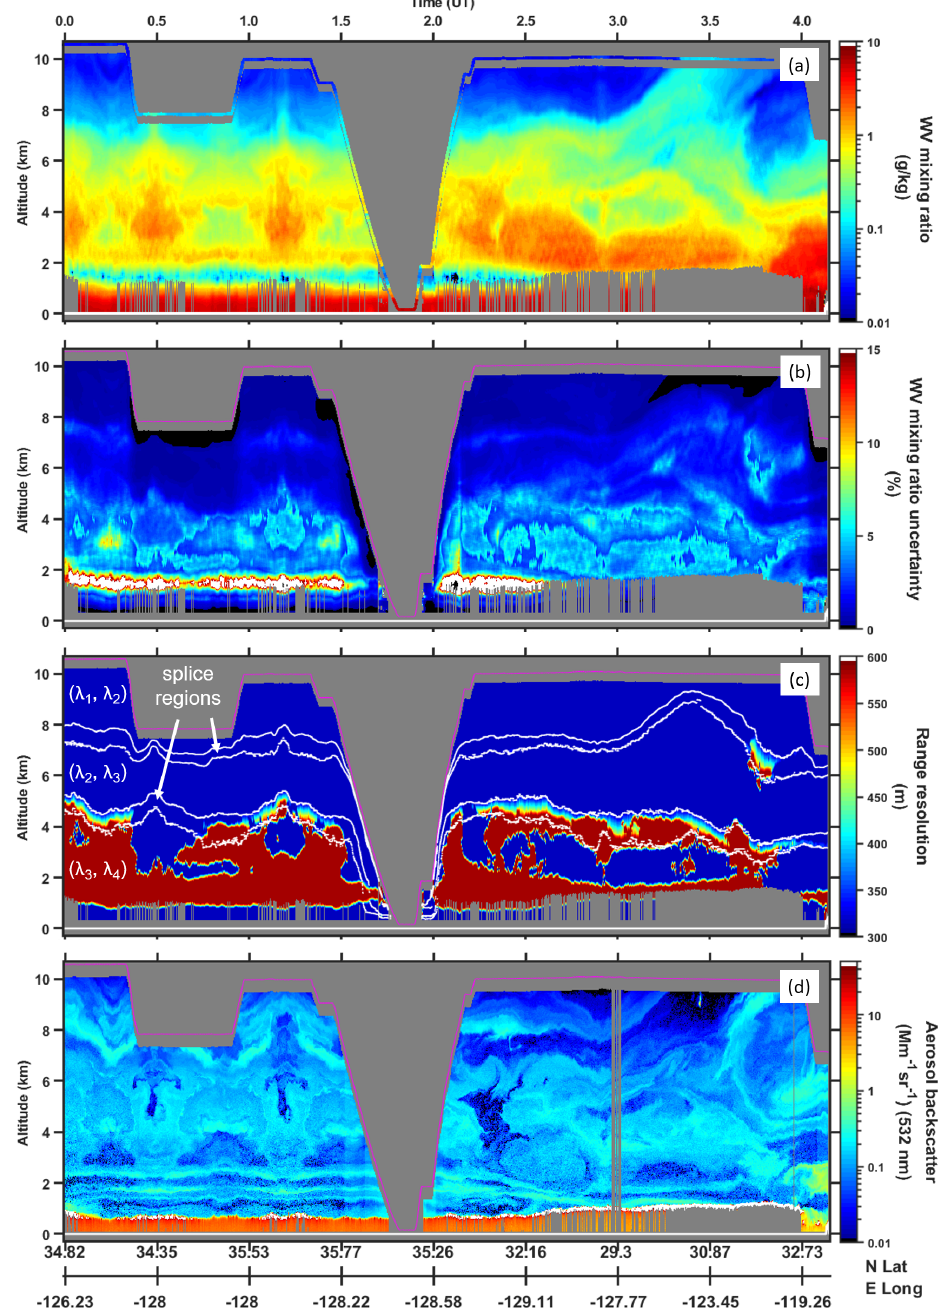
Figure 4. Time–altitude curtains of HALO (a) WV mixing ratio, (b) percent uncertainty, (c) vertical resolution, and (d) HSRL 532nm aerosol backscatter on 30 April. DLH measurements are also shown in panel (a) at the aircraft altitude, whereas aircraft altitude is a magenta line in the other panels. The white lines in panel (c) mark wavelength pair and splicing regions, as